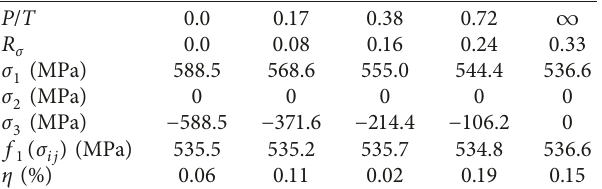
Table 2: The error calculation of the new fracture criterion in different stress